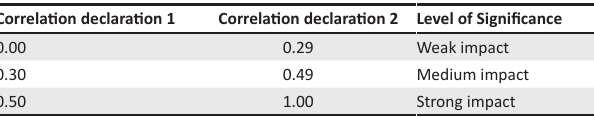
TABLE 4: Pearson’s correlation declaration.